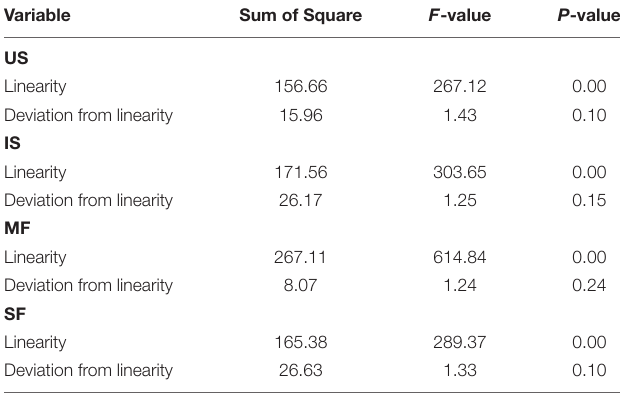
TABLE 5 | Linearity analysis.